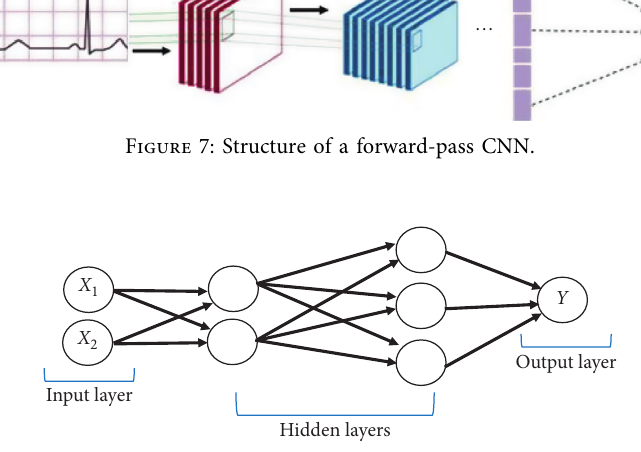
Figure 8: Structure of basic DNN architecture.